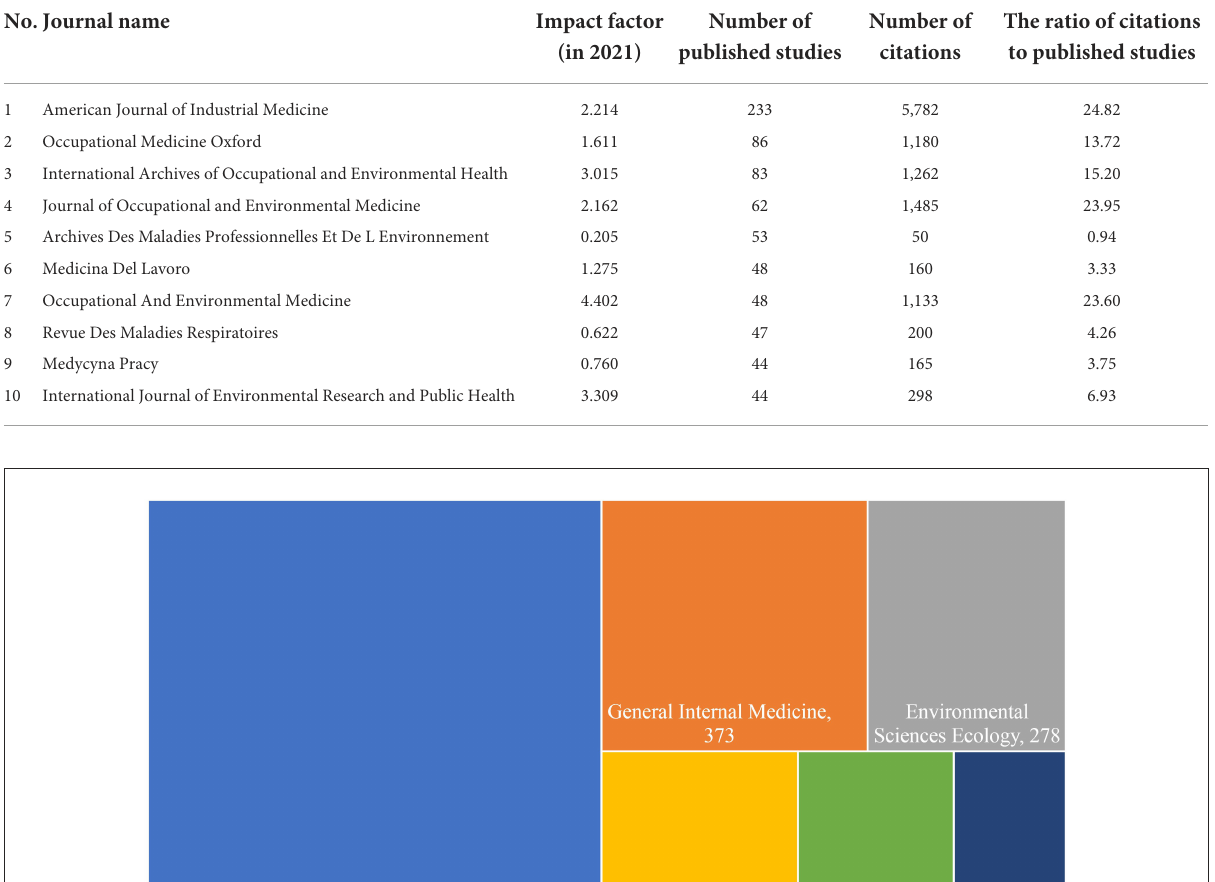
TABLE 2 Top 10 journals with the highest number of published studies on occupational diseases.